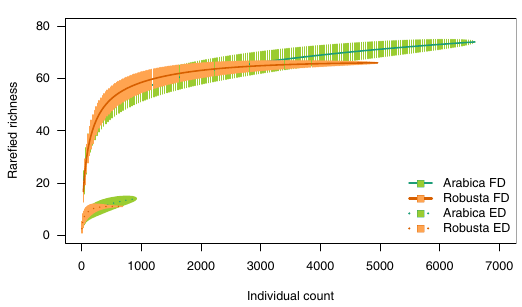
Figure 2. Individual-based rarefaction for arabica and robusta agroforests for forest-dependent (FD) and endemic species richness